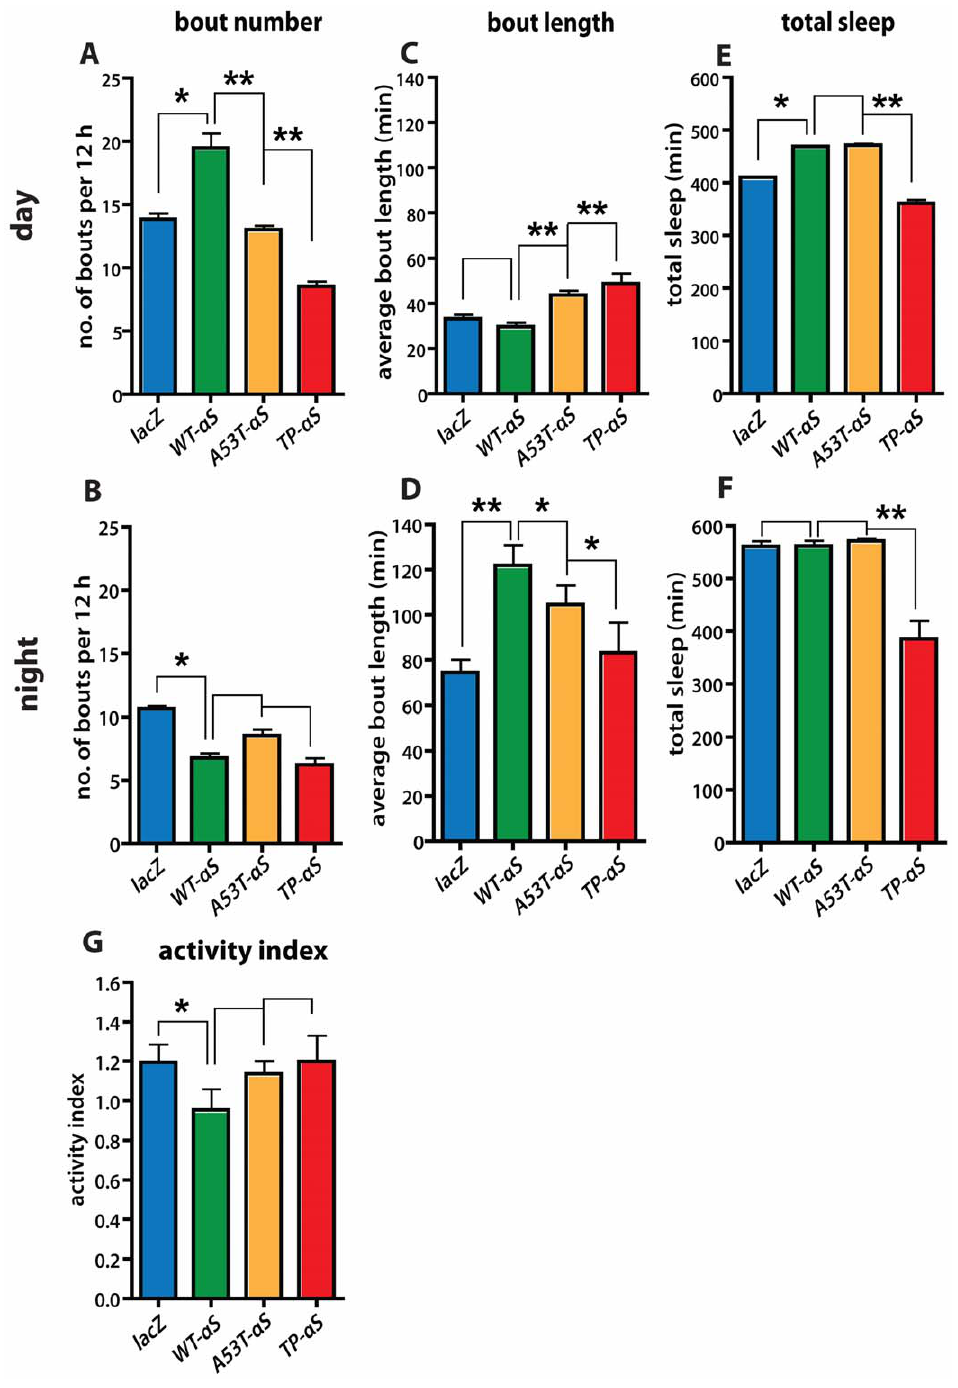
Figure 1. Sleep behavior of flies expressing lacZ , wild type a S and a S mutants from Ddc-Gal4 -driven UAS transgenes. Expression of pre-fibrillar a S mutants (A53T- a S, TP- a S; see text) in young flies (3 days after hatching) affect the average number of sleep episodes (‘‘bout number’’; A , B ), the average length of sleep episodes (‘‘bout length’’; C , D ), and the total length of sleep (‘‘total sleep’’; E , F ) more severely than a S expression both during the light (‘‘day’’; A , C ) and dark (‘‘night’’; B , D ) periods. The activity level during the wake periods (‘‘activity index’’; G ) were not significantly affected. Bars represent mean values of at least three independent experiments 6 the standard error of the mean from 32 animals that were individually recorded in each experiment. Differences among means were determined by one-way ANOVA followed by the Newman-Keuls Multiple Comparison post hoc test using wild type a S (Wt- a S) as control for the mutants; no asterisk: P $ 0.05; one asterisk: P , 0.01; two asterisks: P , 0.001. lacZ and Wt- a S refer to lacZ and wild type a S control expression; A53T- a S and TP- a S to the a S mutants; for details see text.